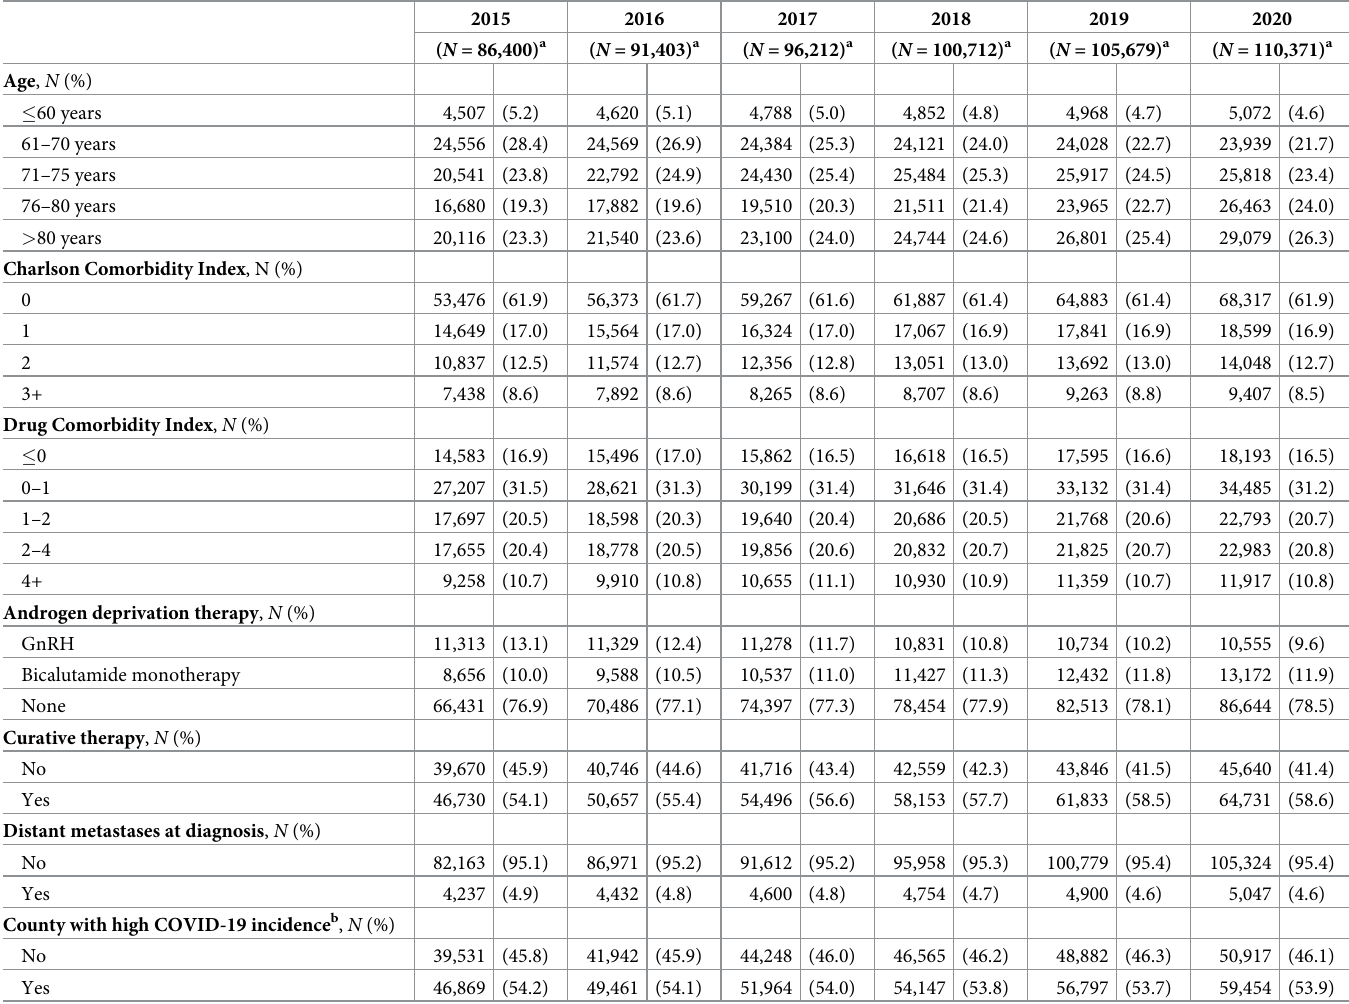
Table 1. Baseline